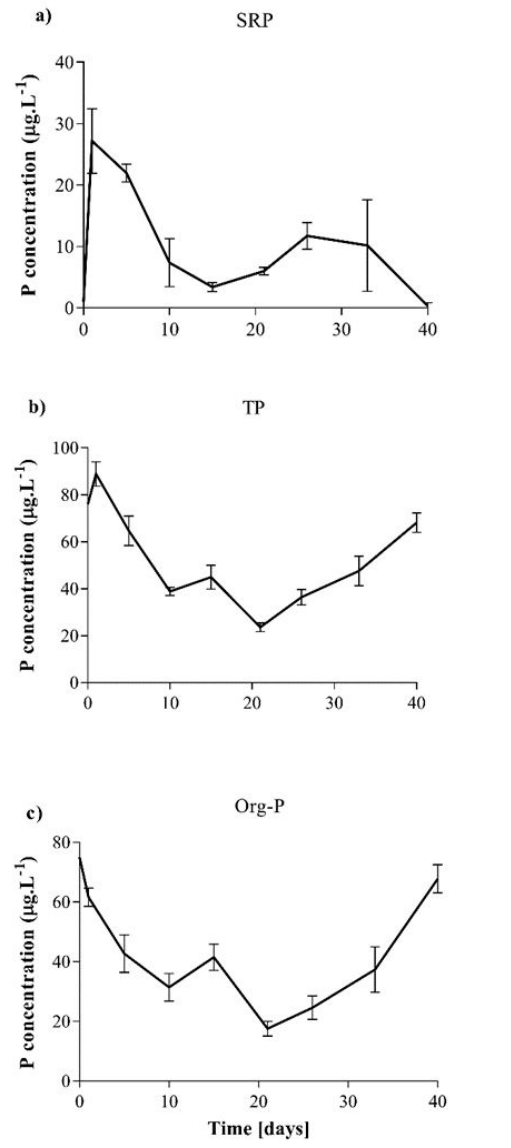
Figure 4. Concentrations of P compounds in the water overlying the sediment. SRP (a), TP (b) and organic P (c). SRP = Soluble reactive phosphorus TP= Total phosphorus Org-P = Organic